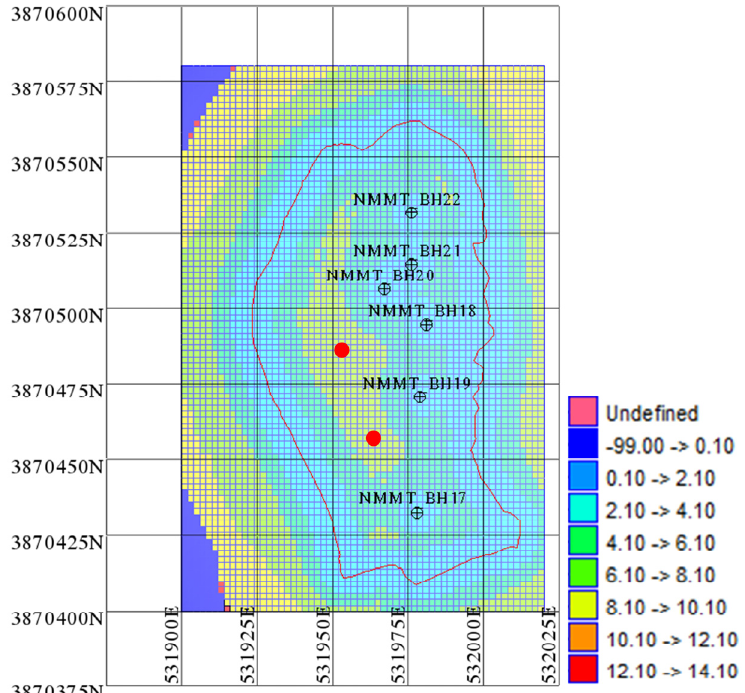
Figure 11. Kriging variance of the final model estimates.